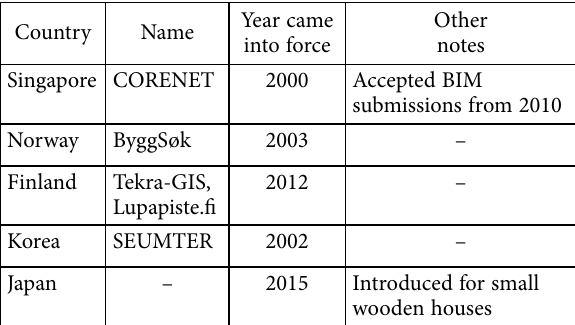
Table 1. E-submission platforms in the AEC